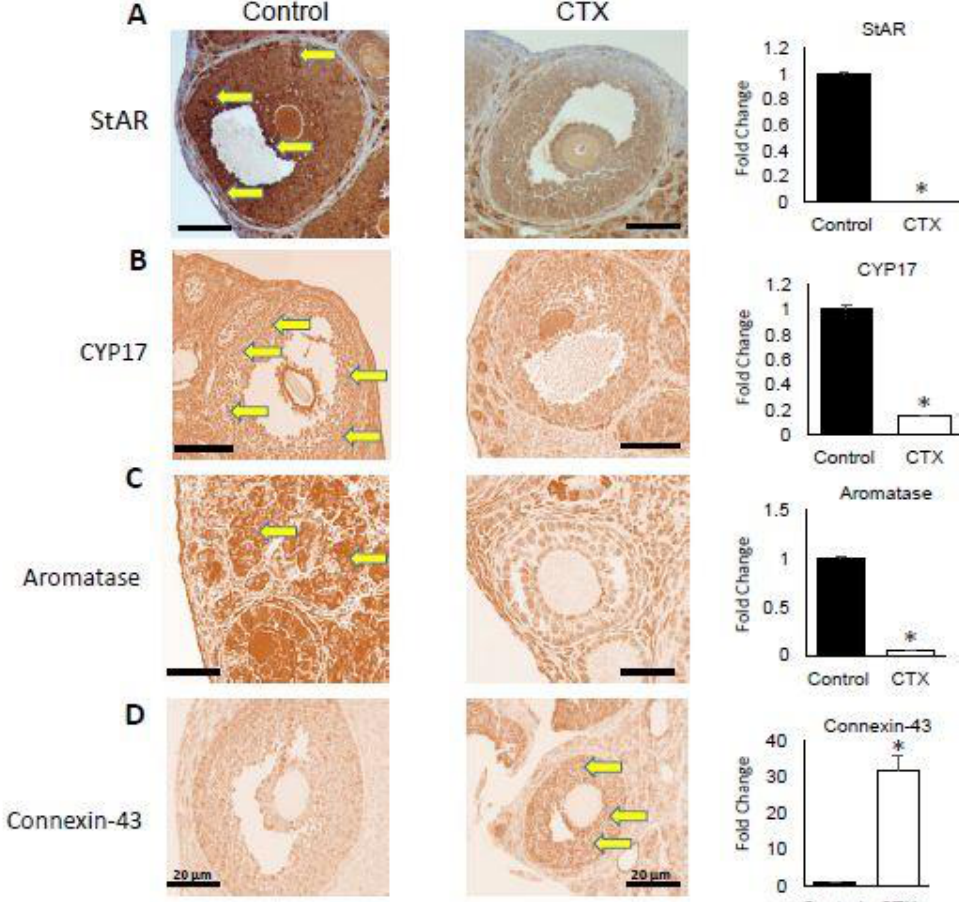
Figure 3. Steroidogenesis markers expressions suppressed by chemotherapy. Cross-section of the ovaries in both the CTX-treated group on the left side and control group on the right side analyzed by immunohistochemistry staining for specific targets involved in the ovarian function supported by fold change (on the right side) for statistical analysis: ( A ) StAR (steroidogenic acute regulatory protein), ( B ) CYP-17 , ( C ) aromatase and ( D ) Connexin-43. For the four markers * p < 0.05. Some slides contain yellow arrows indicating the positive staining in granulosa cells. A Total of 10 sections was analyzed for each markers.